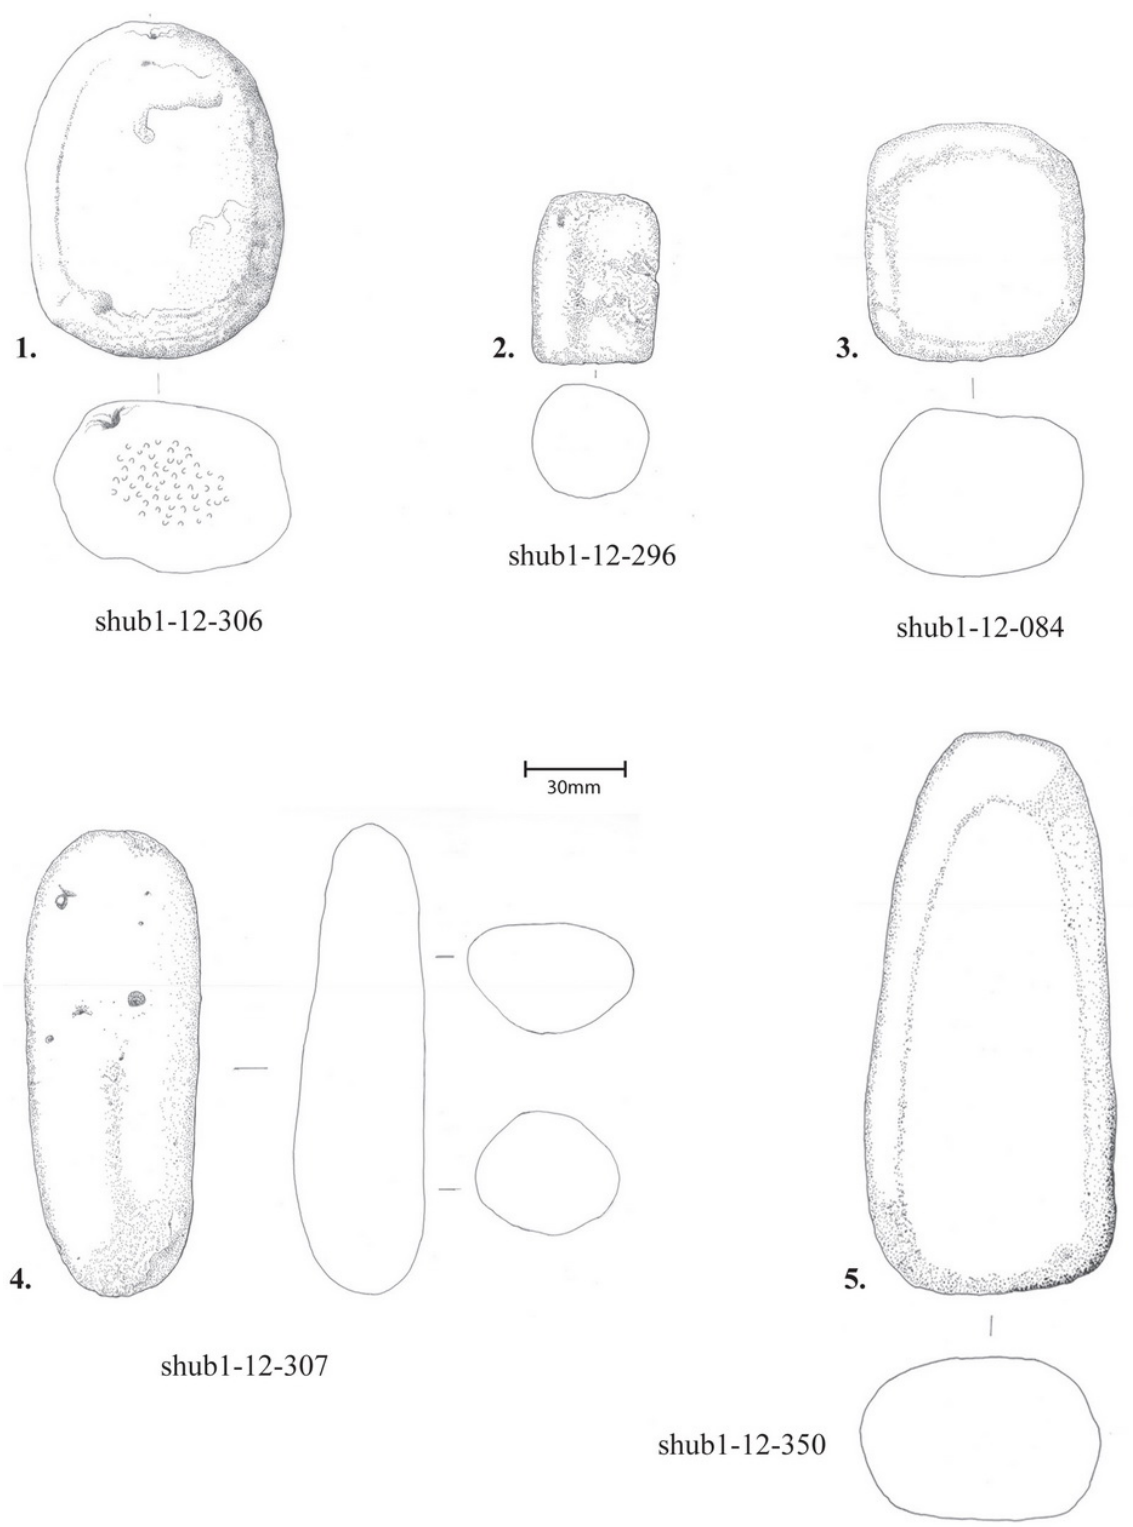
Figure 8: Complete pestles from the late Natufian phases of Shubayqa